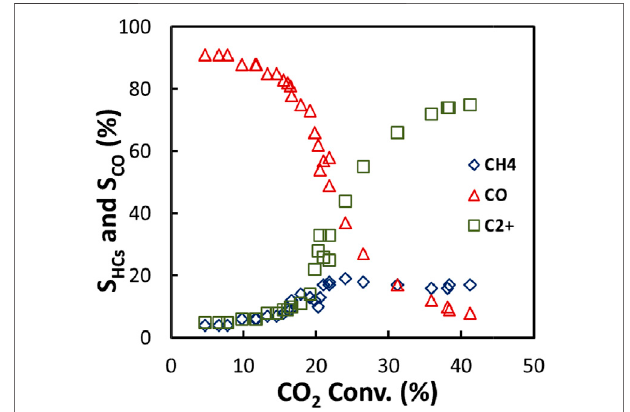
FIGURE13| C 2+ hydrocarbons,CH 4 ,andCOselectivityasafunctionof CO 2 conversionduringCO 2 hydrogenationovertheFe-Cu(0.17)/K(0.3)/Al 2 O 3 catalyst at 573 K and 1.1